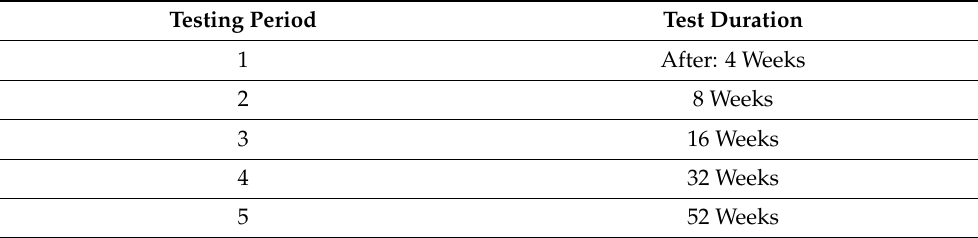
Table 2. Sampling aging